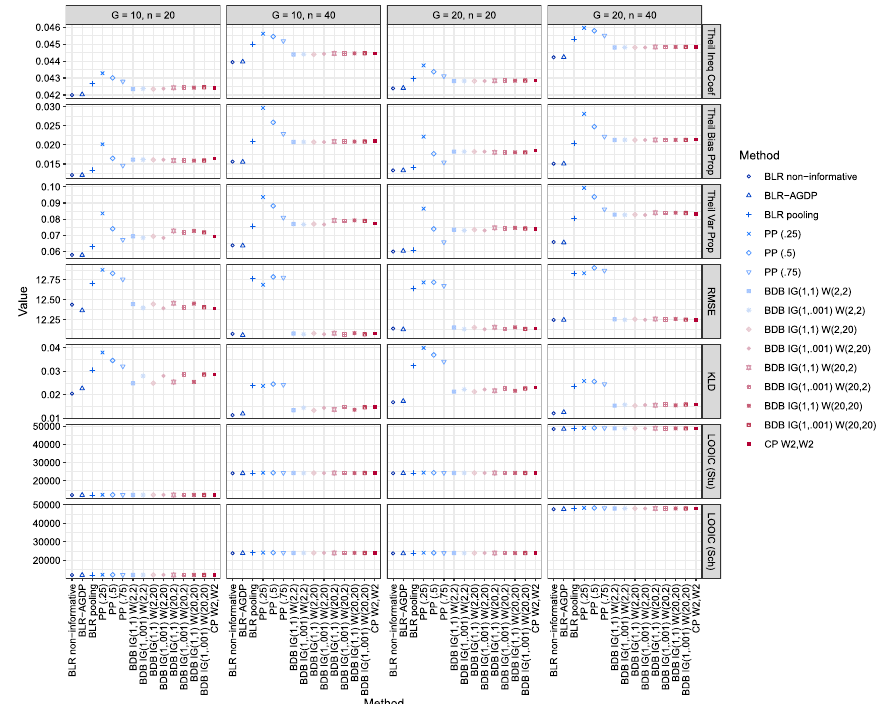
Fig. 4 Prediction performance of different borrowing methods under the homogeneous condition